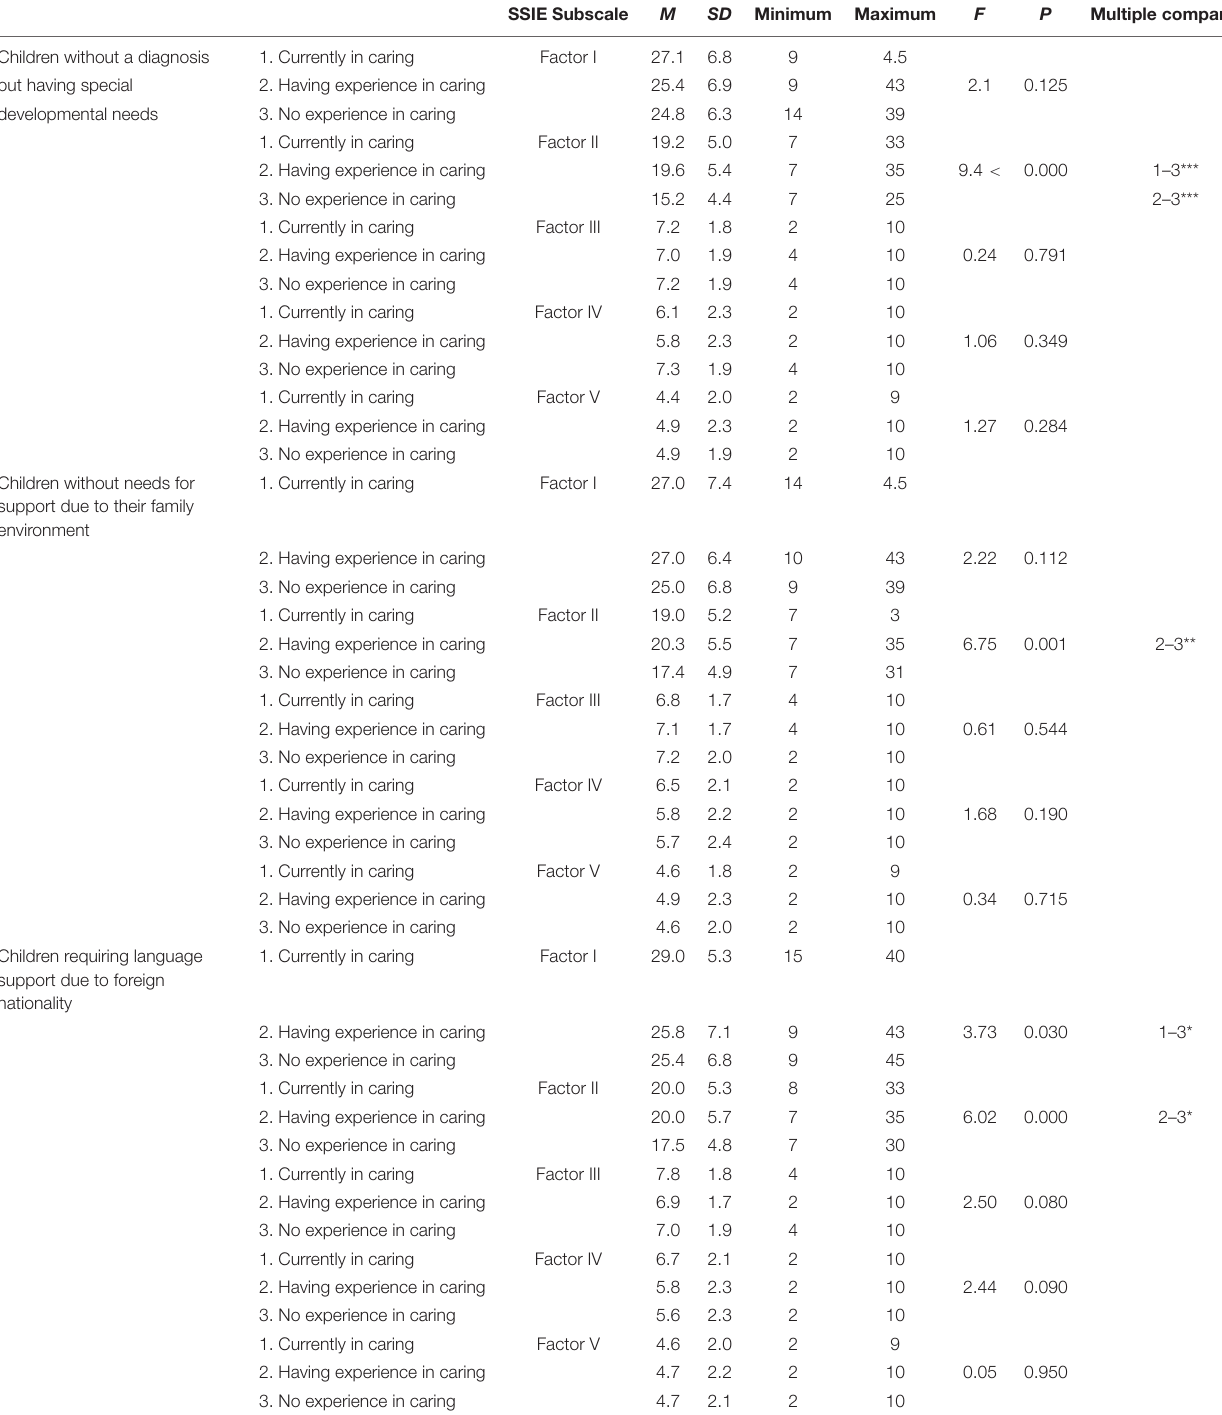
TABLE 4 | A comparison of childcare experiences and stressors for children with special needs. SSIE Subscale M SD Minimum Maximum F P Multiple